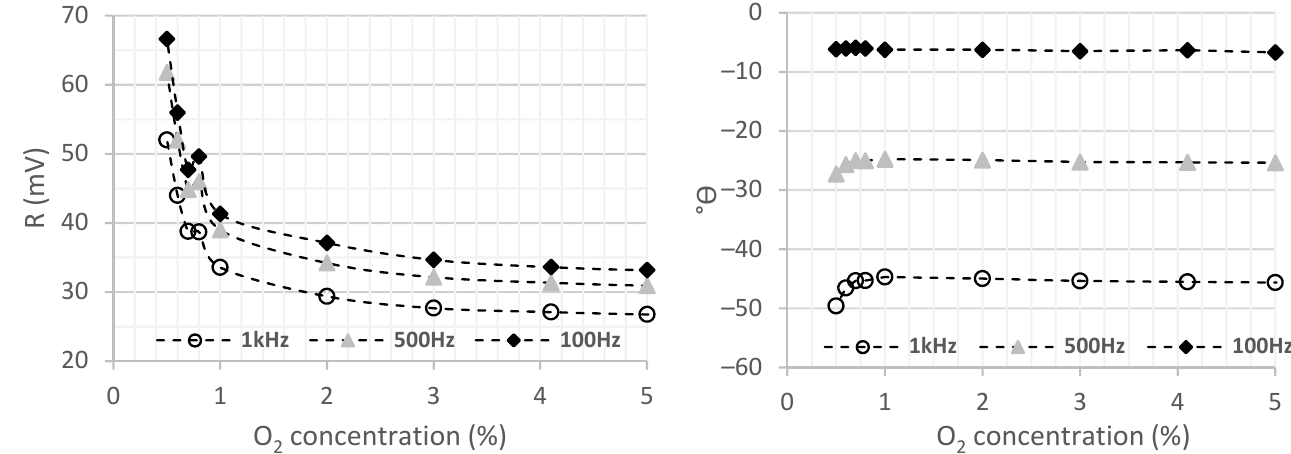
Figure 10. Phase shift of the sensor signal as a function of oxygen variation, for the 363 ppm concentration membrane with a thickness of 1.4 mm and THF in a gaseous environment.